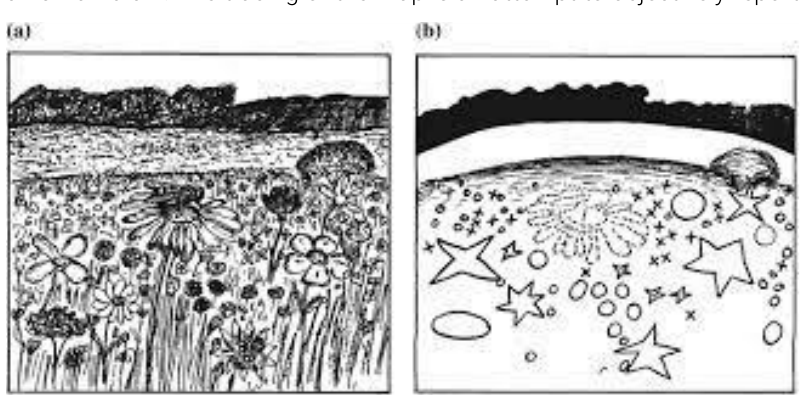
Umwelt of a bee. Image Credit: © Jacob von Uexküll [https://www.researchgate. net/figure/The-Umwelt-of-a-bee-as-illustrated-in-Von-Uexkuell-1934-a-The-